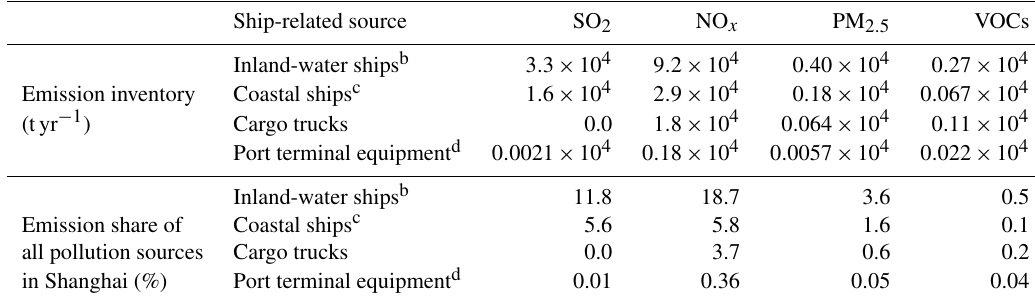
Table 3. Primary emissions (tyr − 1 ) and the emission share of all pollution sources (%) for different types of ship-related sources in Shanghai a in 2015.